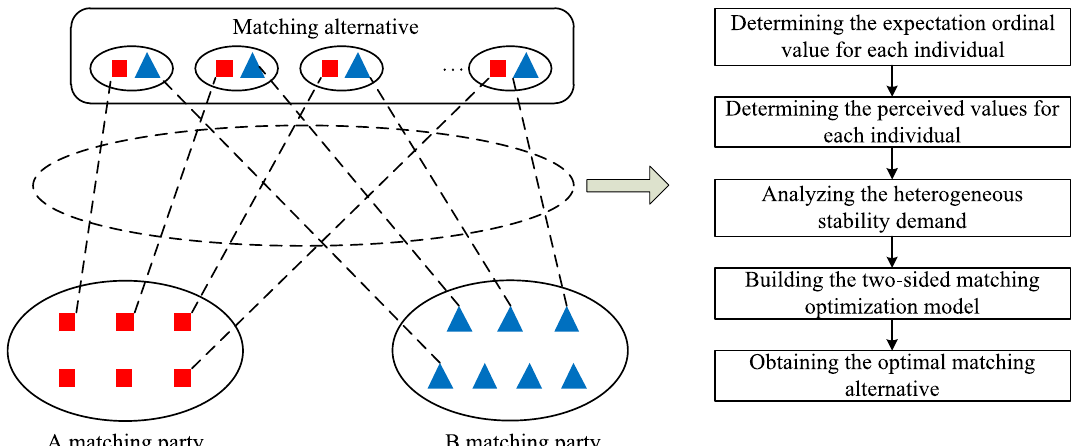
Fig. 1 The framework of TSDM-IH